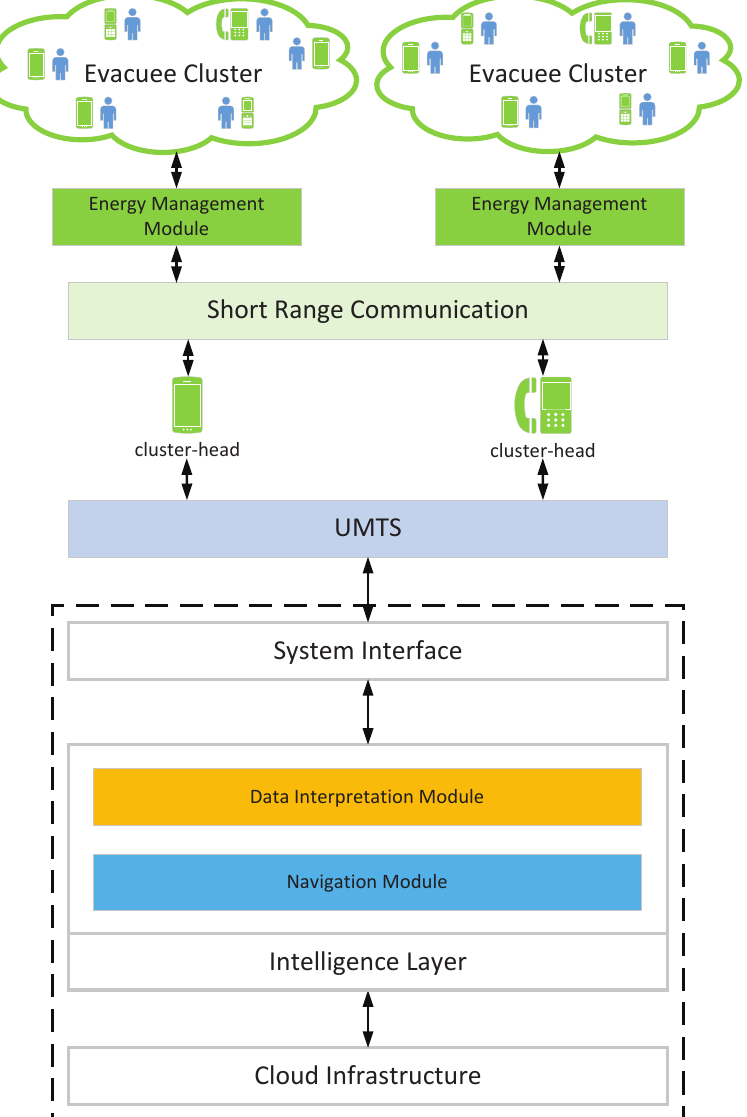
Figure 1. The architecture of the cloud-enabled